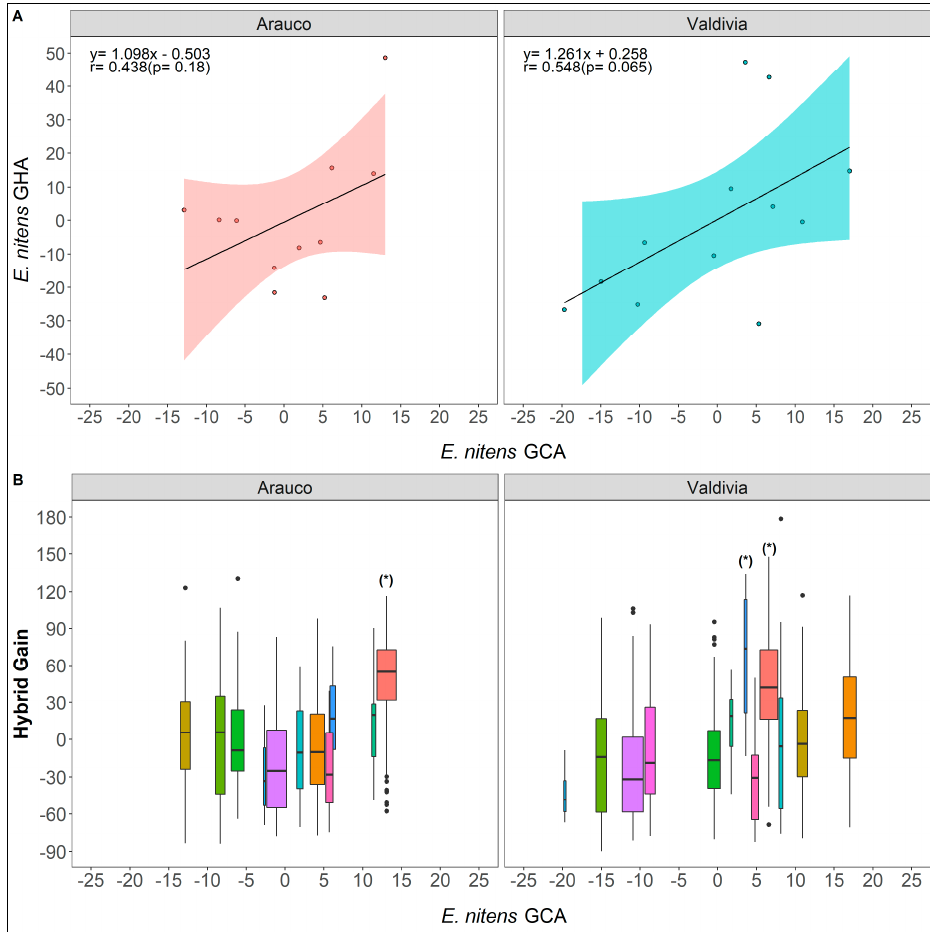
Figure 5. Relationship between E. nitens GCA and their effect in Hybrid Gain and E. nitens GHA for standardized volume (stVol) in the Arauco and Valdivia zones. ( A ) GHA vs. GCA of E. nitens parents, where each dot represents an E. nitens mother, and the significance probability of the correlations is in parenthesis ( p -value). ( B ) Hybrid Gain vs. E. nitens GCA, where each E. nitens parent was represented with a unique color. Identified with an asterisk (*) are E. nitens mothers with clones that, on average, had predicted gains of more than 50% gain relative to the hybrid population mean (zero).